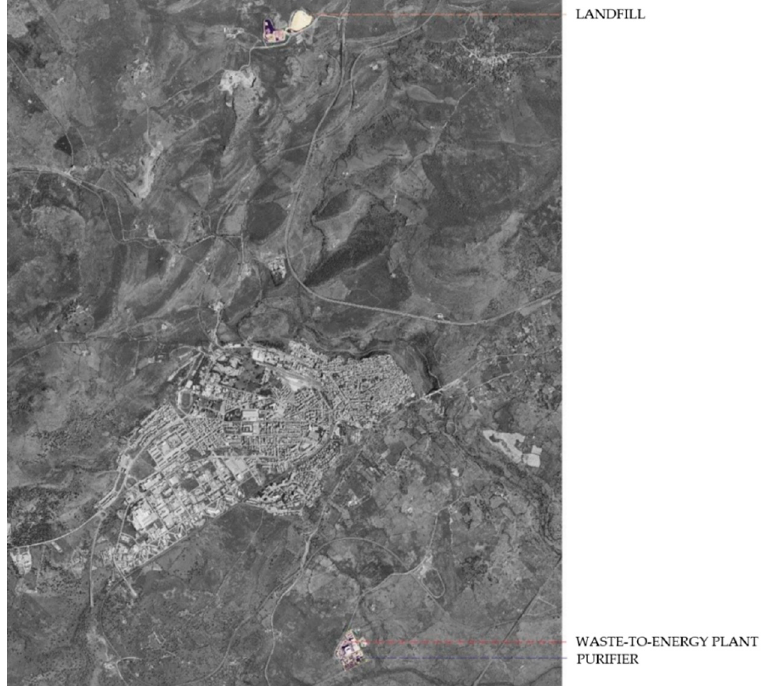
Figure 2. Location of industrial waste management plants near the urban area of Macomer, the most populated municipality in Marghine. populated municipality in